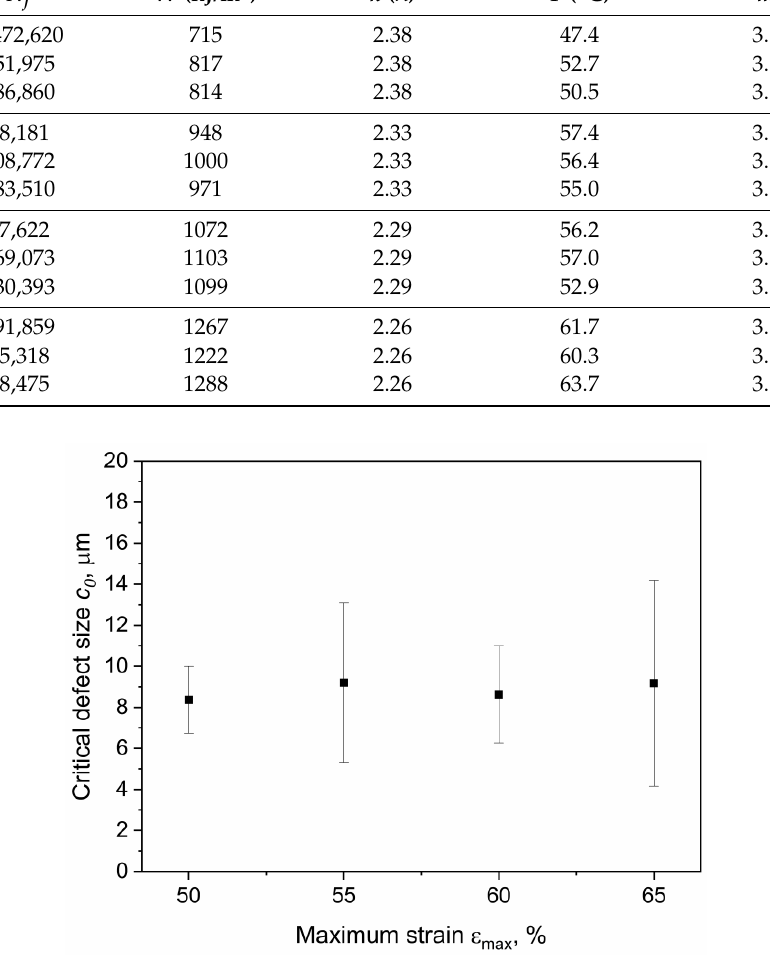
Figure 15. Critical defect size c 0 at different strains evaluated from fatigue data using Equation (10). The fatigue tests were implemented on axisymmetric dumbbell specimens of CB filled NBR at a frequency of 4 Hz and a load ratio R ε of 0.5. Table 1. Overview of the values used to calculate the critical defect size with the reversion of Equa- tion (10). The values of the number of cycles to failure are the same as reported in Figure 3.